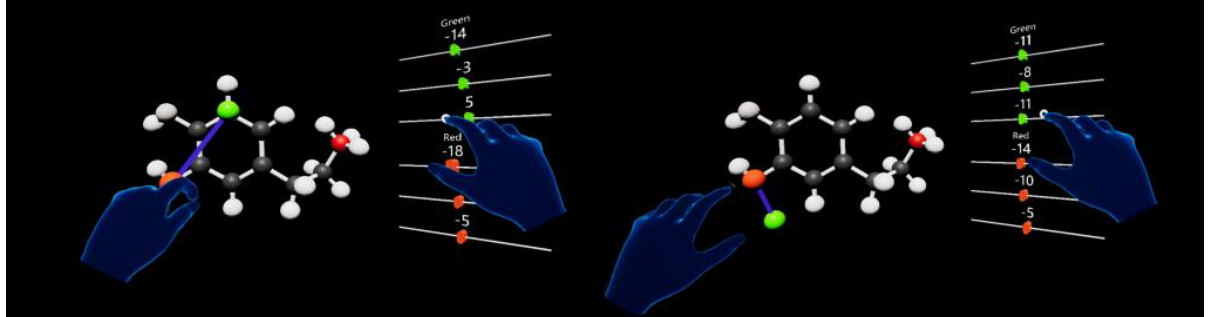
Figure 5. MR in medical chemistry, displayed in front of the users wearing Microsoft HoloLens2.